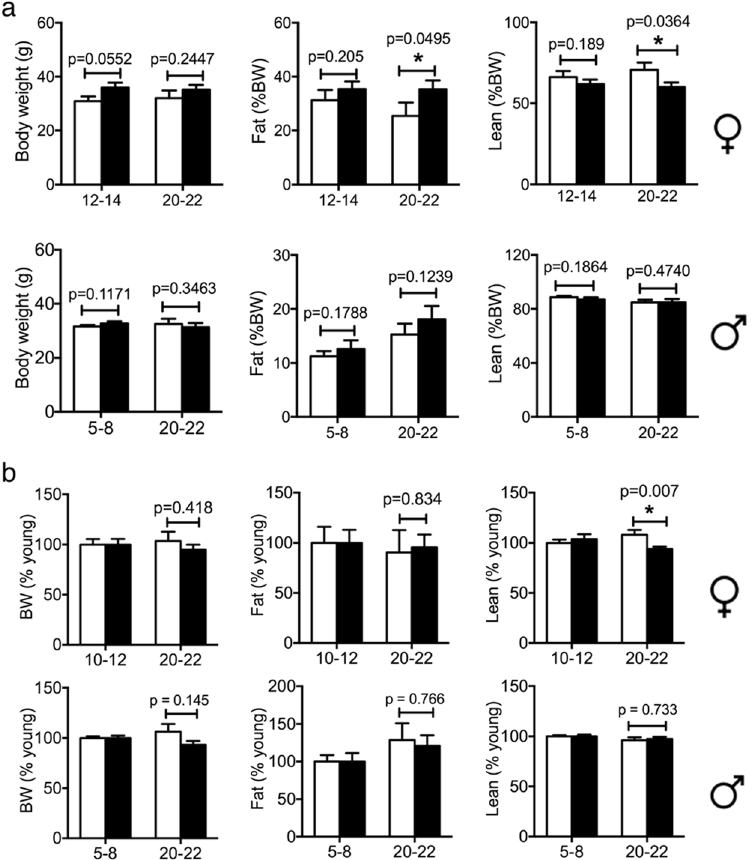
Figure 2. Body weight and composition. Body weight and composition of mice at different ages (specified in the figure) were determined using magnetic resonance imaging approach as described in the method section. ( a ) Body weight, lean and fat mass to body weight ratio. ( b ) Body weight, lean and fat mass normalized to young mice with the same gender and genotype. Male: 5–8 m mice, n = 17 for WT, n = 13 for TSC1 tg ; 20–22 m mice, n = 18 for WT, n = 10 for TSC1 tg . Female: 12–14 m mice, n = 14 for WT, n = 15 for TSC1 tg ; 20–22 m mice, n = 12 for WT, n = 19 for TSC1 tg . The asterisks indicate statistical significance between Tsc1 tg and wild type mice ( * p <